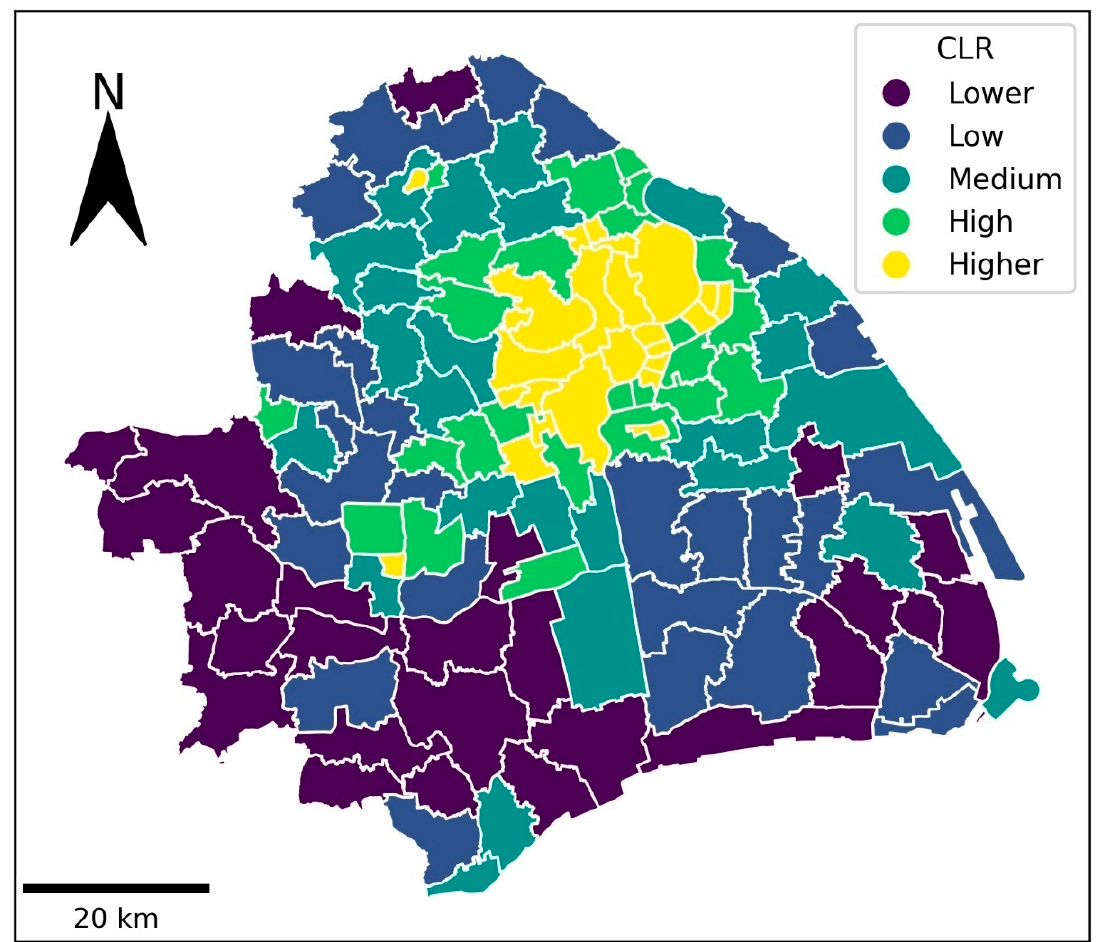
Figure 4. The consumption level of residents in the sample study area.